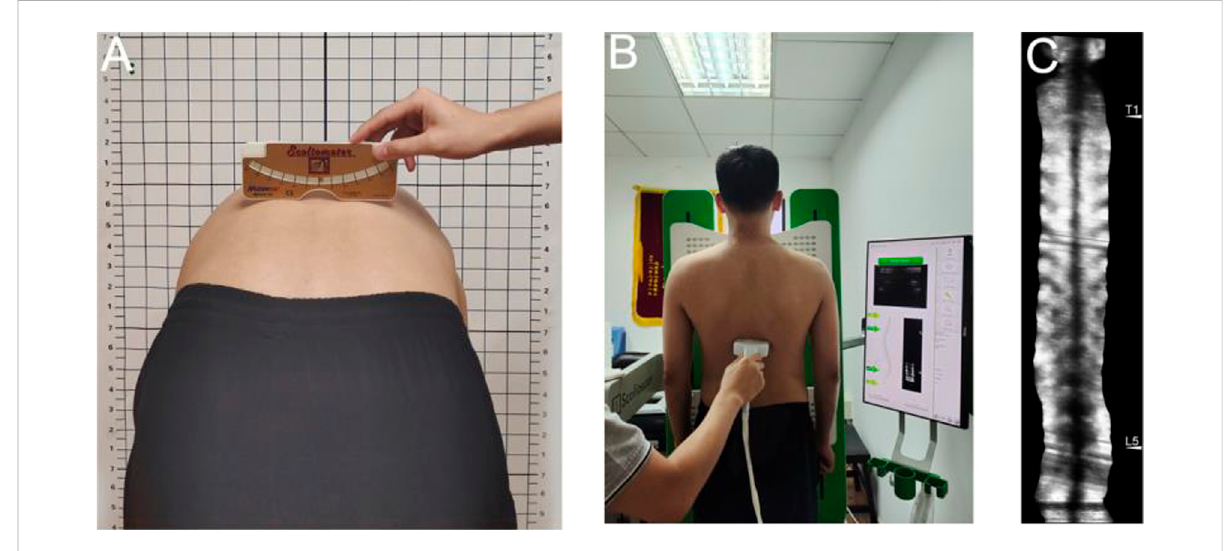
FIGURE 1 Scoliosis screening methods- (A) Adam ’ s test and trunk rotation angle measured with a Scoliometer; (B) A radiation-free spine ultrasound imaging system; (C) Ultrasound